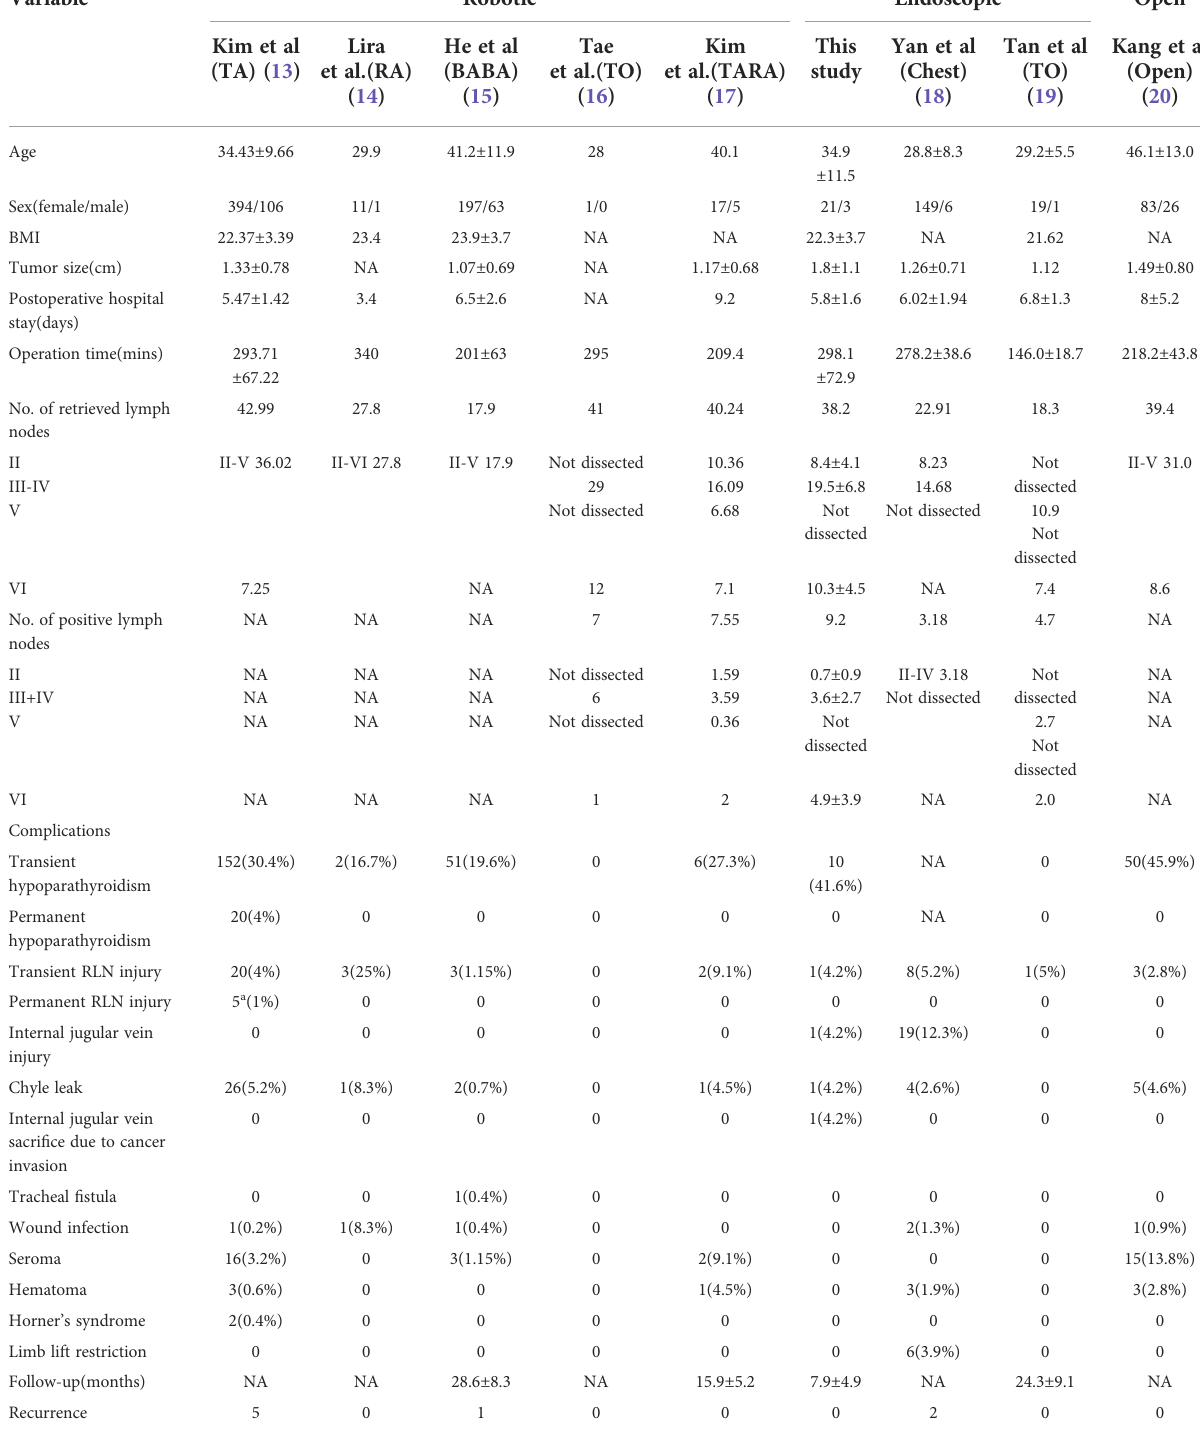
TABLE 1 Surgical outcomes of thyroid cancer patients who underwent robotic/endoscopic/open LND.